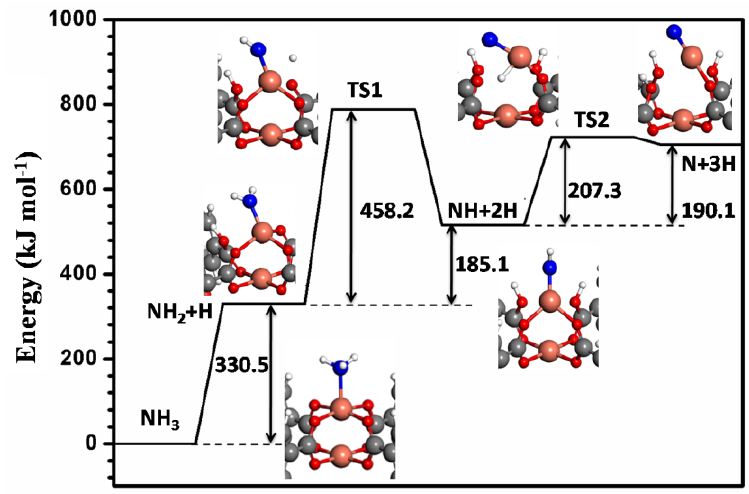
Figure 2. Reaction paths for NH 3 dissociative adsorption on Cu-HKUST-1. TS1 is the transition state for NH 2 dissociation into NH + H. TS2 is the transition state for NH dissociation to N + H. Adsorbate geometries present in the local MOFs region. The color scheme is the same as for Figure 1.